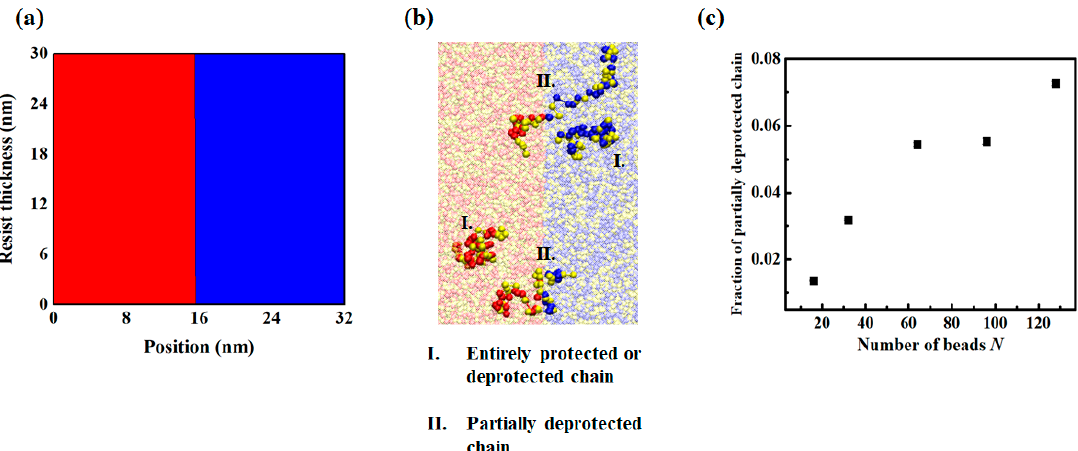
Figure 3. ( a ) Aerial image profile used for an infinite contrast. ( b ) Snapshot of selected chains near the